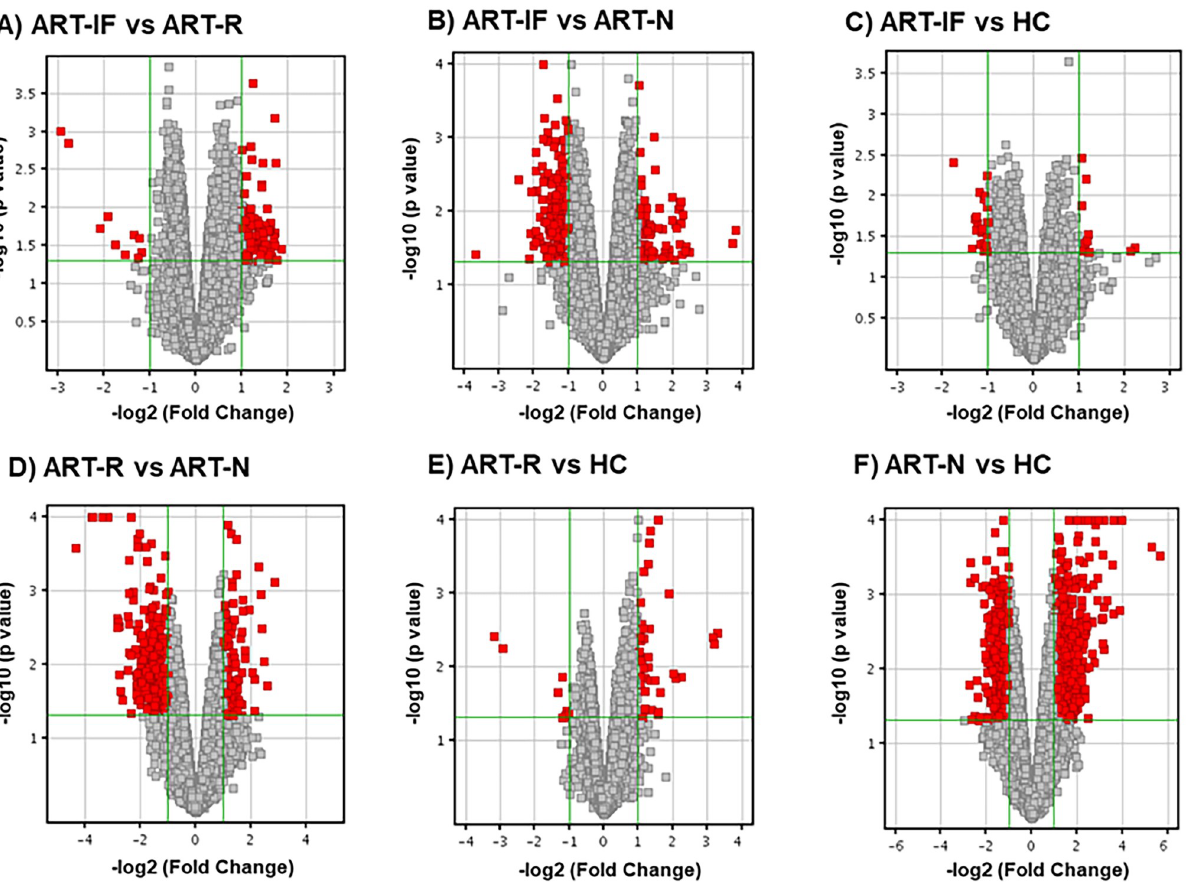
Fig 3. Volcano plots showing the distribution of significantly upregulated and downregulated genes. Volcano plots were constructed by plotting the negative log of the p-value on the y-axis (-log10). The x-axis is the log of the log fold change among different groups. Distribution of downregulated and upregulated genes among ART-IF, ART-R, ART-N, and HCs.